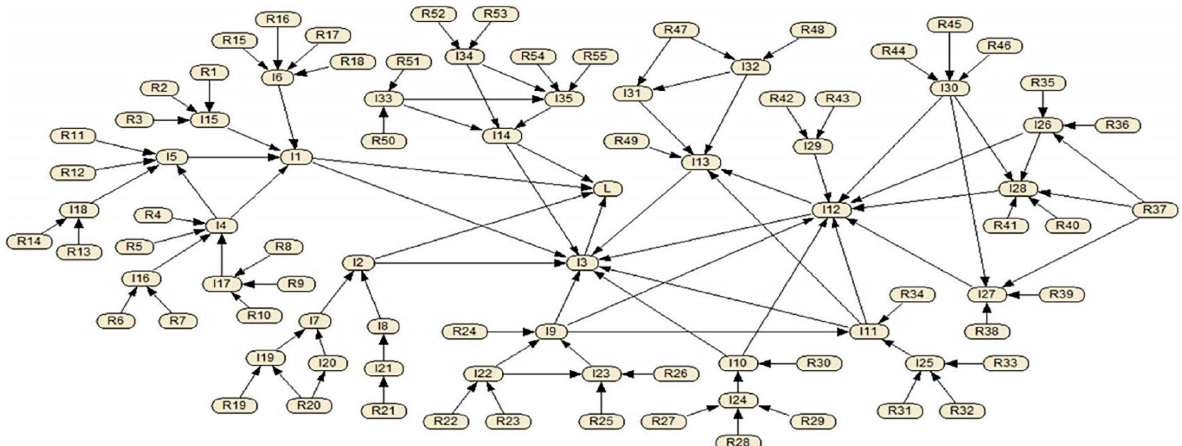
Figure 4. A BBN structure of the identified RFs for ICPs (with 91 nodes and 111